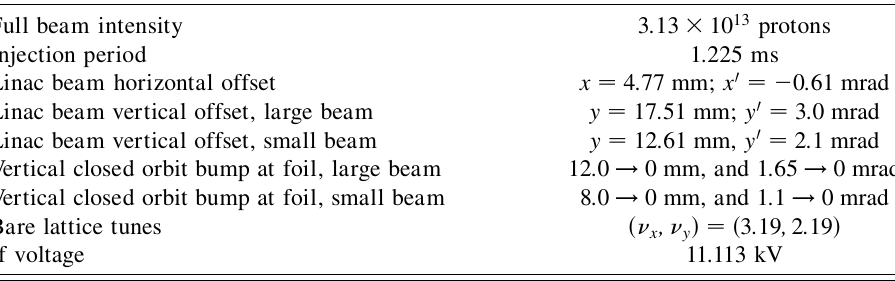
TABLE III. Parameters for the injection painting experiment.